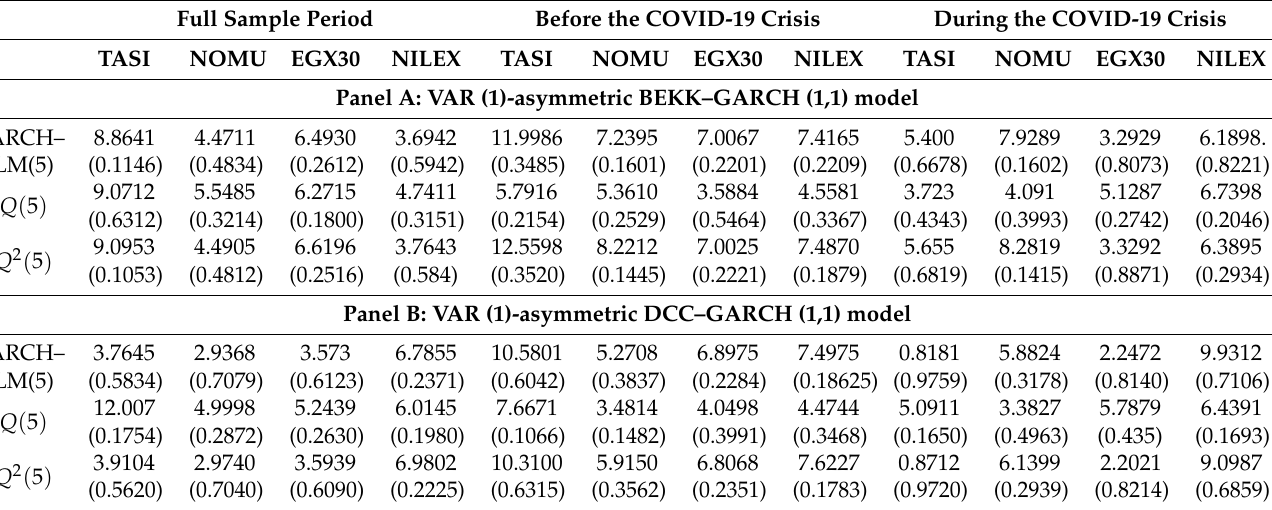
Table A2. Diagnostic tests on standardized